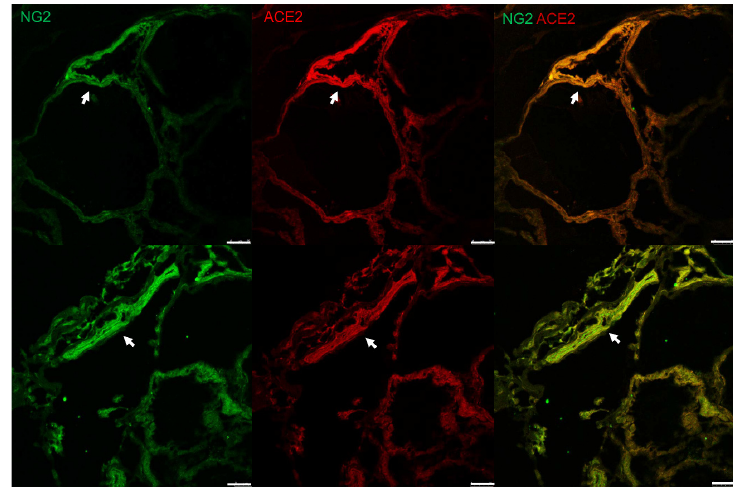
Figure 4. Expression of ACE2 in pericytes. Immunofluorescence staining showed that ACE2 was expressed in the interfollicular microvessels (arrow), and localization of ACE2 (middle panel, red) coincided with the expression of the pericyte marker NG2 (left panel, green). Scale bar = 20 μ m. ACE2, angiotensin-converting enzyme 2; NG2, nerve/glial antigen 2. ACE2 and TMPRSS2 expression in the human thyroid was not significantly different from that in the rat thyroid. Graves’ disease has a larger colloid and more abundant mi- crovessels around the follicle than those found in normal or Hashimoto’s thyroiditis-af- fected thyroids. ACE2 was stained only in microvessels in the normal thyroid, Hash- imoto’s thyroiditis, and Graves’ disease. Expression seemed more abundant in Graves’ disease than in the normal or Hashimoto’s thyroiditis-affected thyroids because of the in- creased number of microvessels around the follicle. TMPRSS2 was stained in the colloid of the normal thyroid, Graves’ disease, and Hashimoto’s thyroiditis, and was more strongly expressed than in rats (Figure 5).